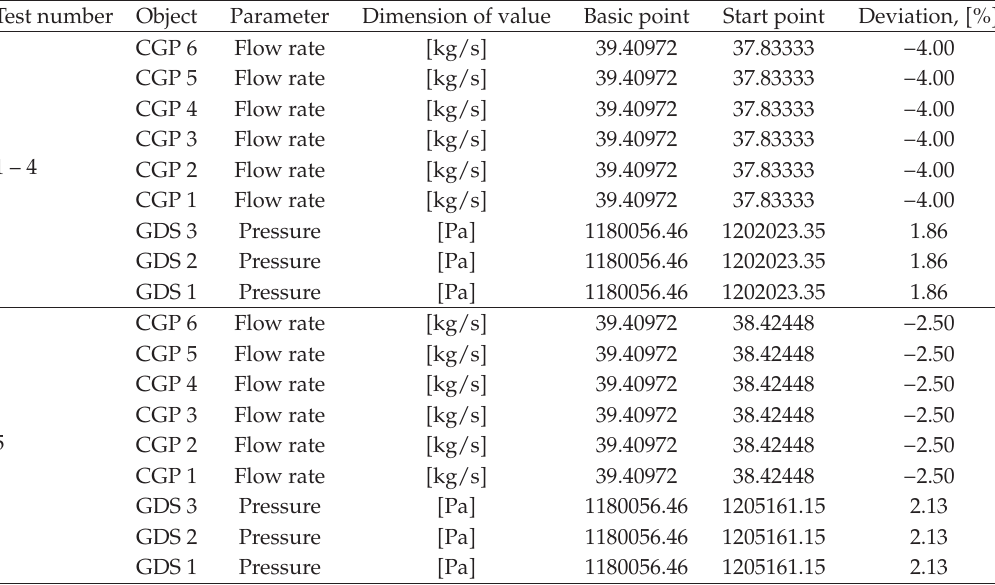
Table 8: Starting point of Stage 2 of the test simulation.